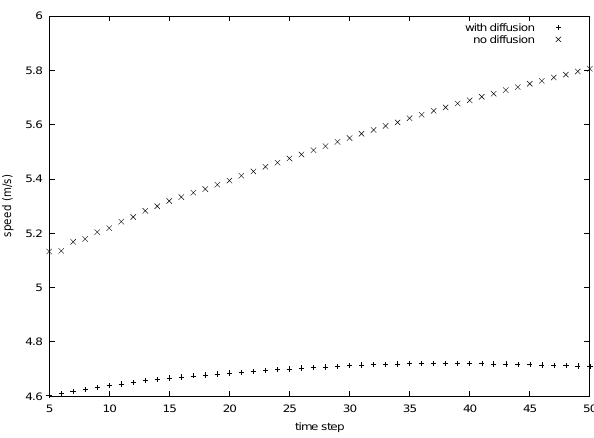
Fig. 4. The BOLAM wind speed, at lowest sigma level, averaged on the domain for the experiments with and without diffusion, in the former three hours of